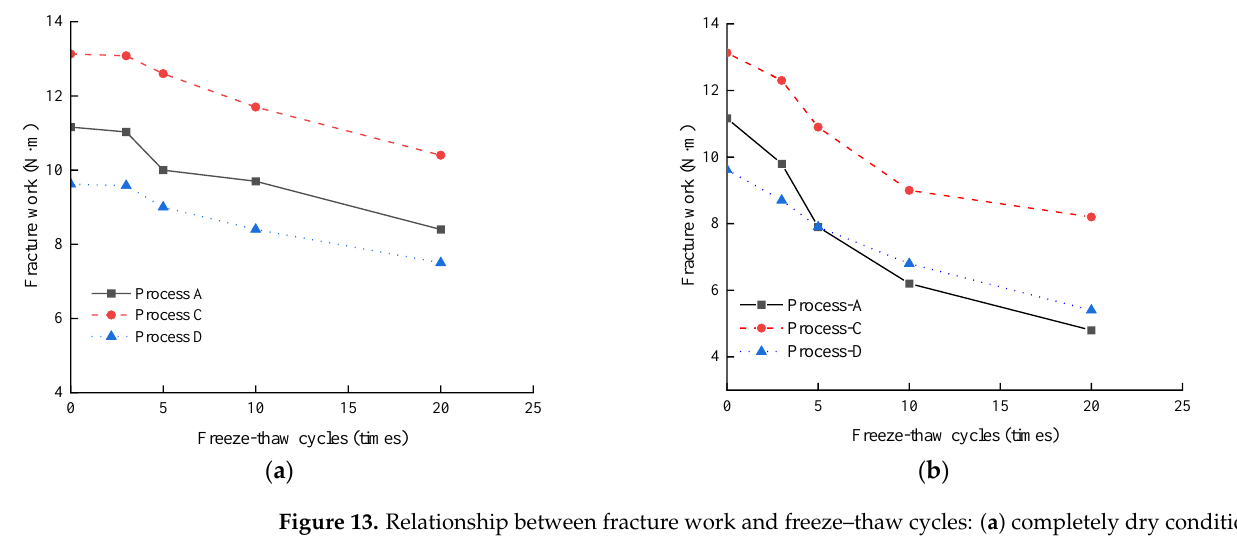
Figure 12. Relationship between splitting strength and freeze – thaw cycles: ( a ) completely dry con- dition; ( b ) water saturation condition.